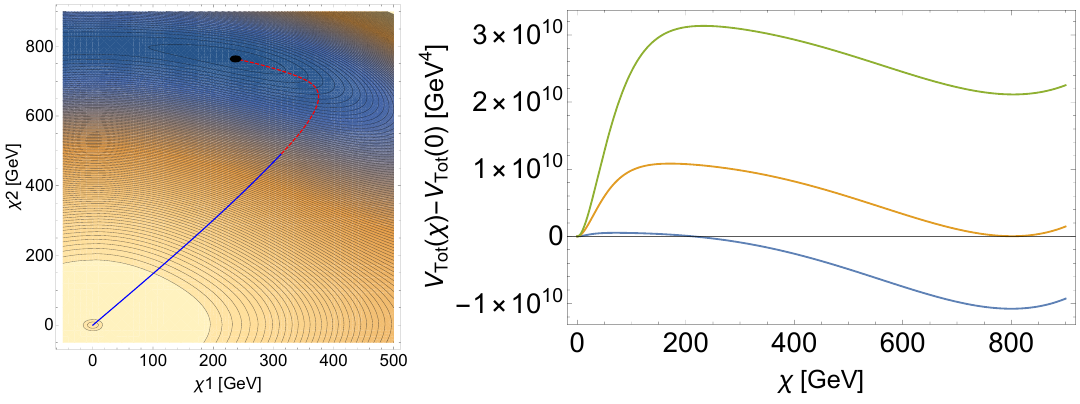
Figure 6 . Left: potential as a function of (cid:31) 1 and (cid:31) 2 for a meson-like dilaton with mass m (cid:31) = 500 GeV and N = 5 and evaluated at the nucleation temperature T n ’ 65 : 6 GeV. The other parameters are as in table 2. The solid blue line shows the tunnelling path to the release point, while the red dotted line indicates the subsequent rolling trajectory towards the minimum of the potential. Right: potential at, from bottom to top, the nucleation temperature T n ’ 65 : 6 GeV, the critical temperature T c ’ 138 : 3 GeV and T = 180 GeV. The potential is plotted along the straight line parametrized by (cid:31) connecting the minimum at the origin with the second minimum at f (cid:31) 1 ; (cid:31) 2 g ’ f 238 GeV ; 764 GeV g , f 175 GeV ; 782 GeV g and f 0 GeV ; 804 GeV g ,